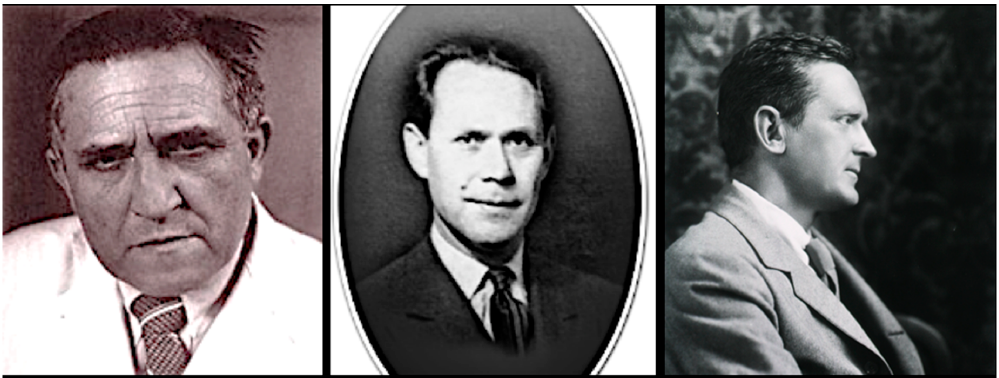
Figure 3. Typhus troika working at the American Hospital in Mexico City: ( left ) Hermann Mooser; ( center ) Maximiliano Ruiz Casteñada; ( right ) Hans Zinsser. They also determined that rats harbor the FBT rickettsiae [107].